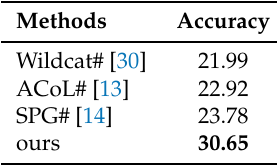
Table 5. Corloc results (%) on the VOC2007 test set.